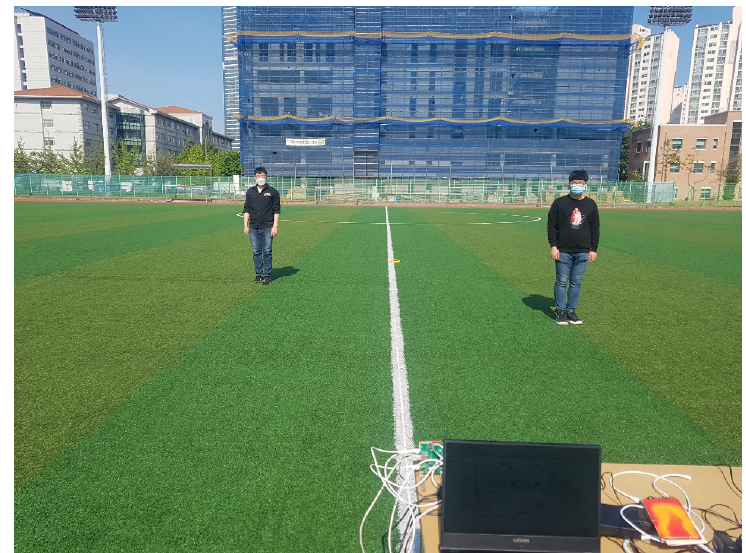
Figure 10. Experiment setup to measure the distributed FMCW radar signals.